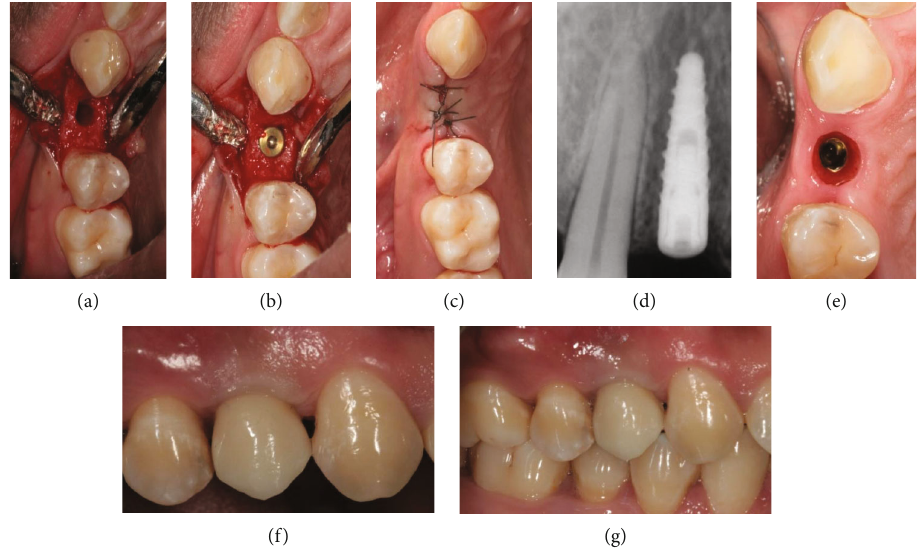
Figure 4: (a) Implant site preparation; (b) implant placement; (c) suture; (d) periapical radiograph after implant placement; (e) soft tissue conditioning; (f) screw-retained zirconia crown; (g) follow-up 6 months after fi nal